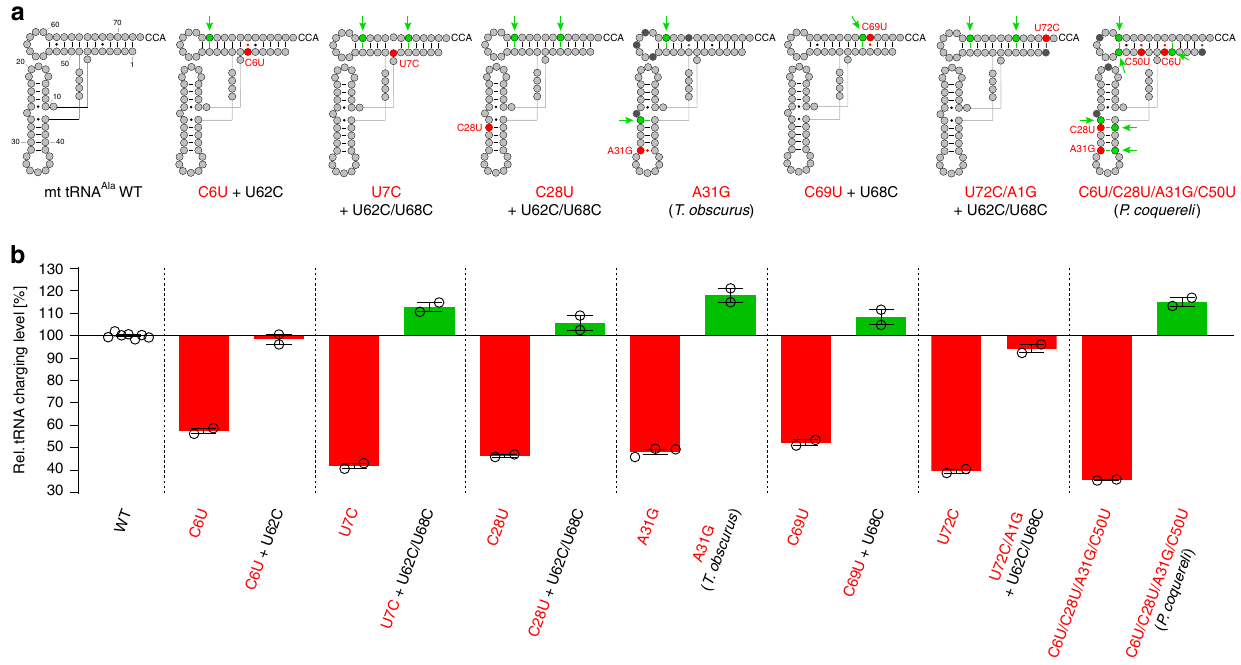
Fig. 3 Compensatory epistasis in Hs mt tRNA Ala . a Hs mt tRNA Ala is presented in schematic L-shape. Shown is a subset of constructs used in this study that showed compensatory epistasis between sites. Red indicates initial mutations that reduce charging. The positions for compensatory mutations that restore charging are shown in green and are indicated by arrows. “ T. obscurus ” and “ P. coquereli ” denote the mt tRNA Ala ’ s from two primate species that contain known human disease-causing mutations in an overall altered sequence context. Black circles indicate positions with sequence alterations relative to wild-type (WT) Hs mt tRNA Ala with unknown effects on stability. b Relative charging levels for mt tRNA Ala constructs containing the destabilizing mutation alone or in combination with compensatory mutations. The charging level of wild-type Hs mt tRNA Ala is set to 100%. Error bars represent the SEM of two to six independent experiments. Source data are provided as a Source Data fi le (see also Supplementary Figs. 4 – 6 and Table 2 for data on the complete set of compensatory mutations used in this